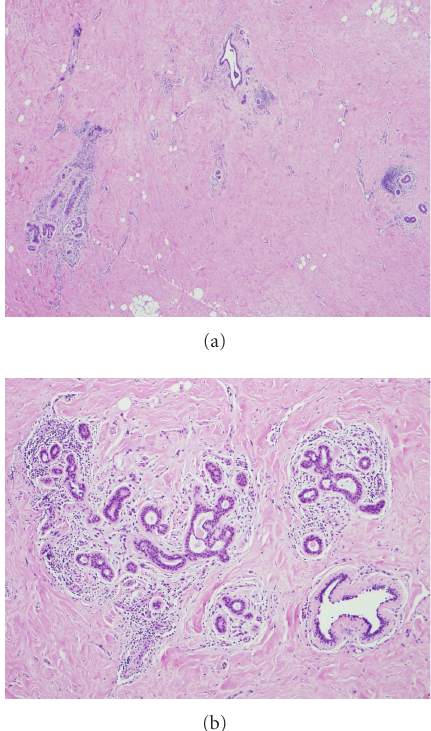
Figure 2: Ultrasound of the palpable abnormality in the left breast shows normal tissue with no mass.